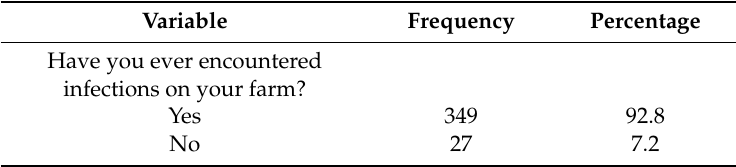
Table 2. The knowledge and usage of antibiotics by livestock